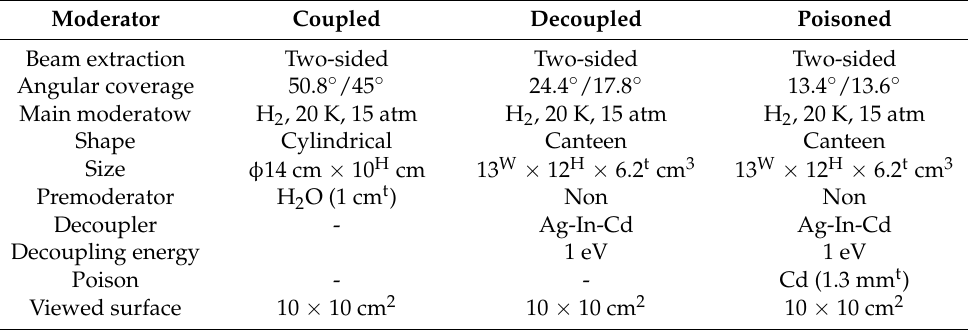
Table 2. Major specifications of moderators employed at